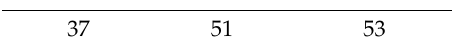
Table 5. Vehicle speeds km/h.